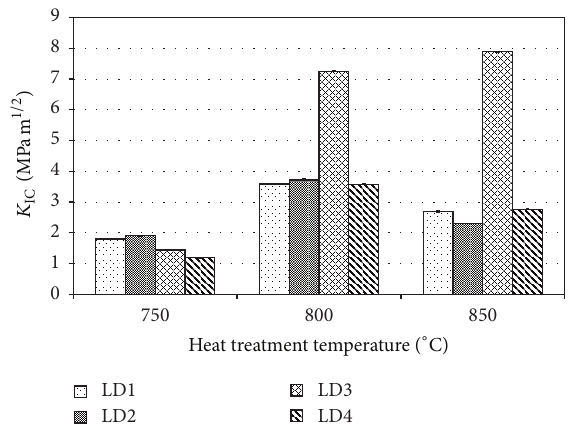
Figure 6: The fracture toughness of LD1, LD2, LD3, and LD4 heat treated at different temperatures for 2hrs.